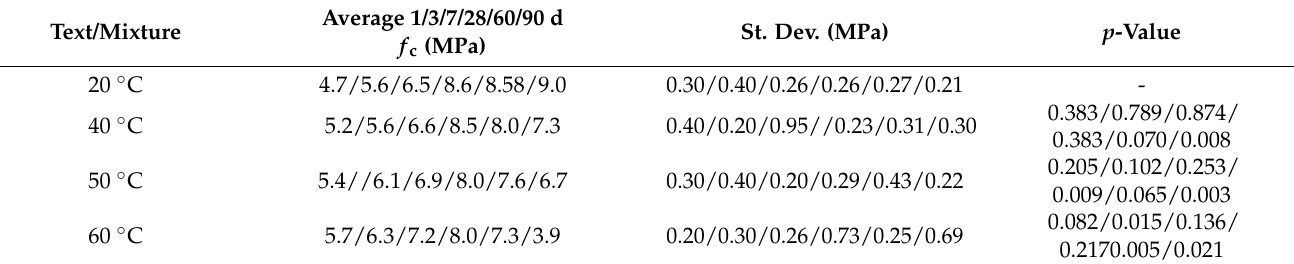
Table 5. Reliability analysis of flexural strength test